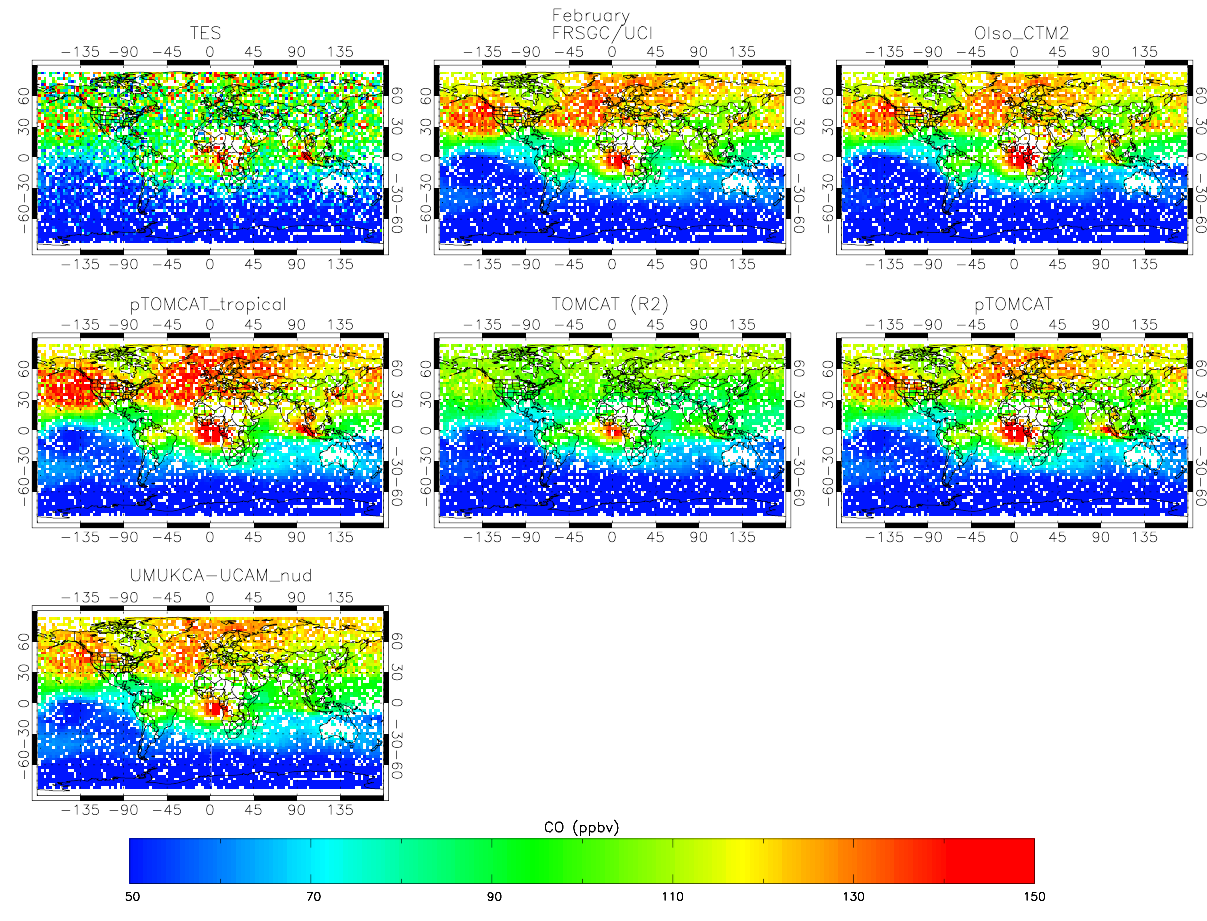
Fig. 11. A comparison between TES (Tropospheric Emission Spectrometer) satellite-based measurements of CO, and the monthly mean modelled CO mixing ratio at 350hPa, for February